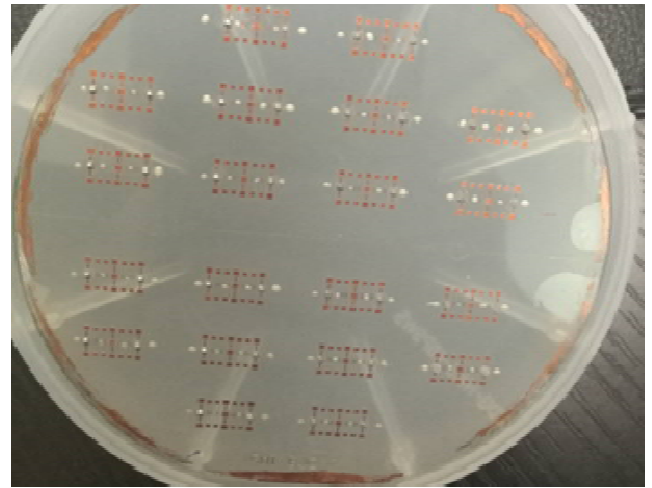
Figure 5. Samples of the amorphous alloy wire magnetic sensor. An array of 20 magnetic sensors is distributed on the wafer.